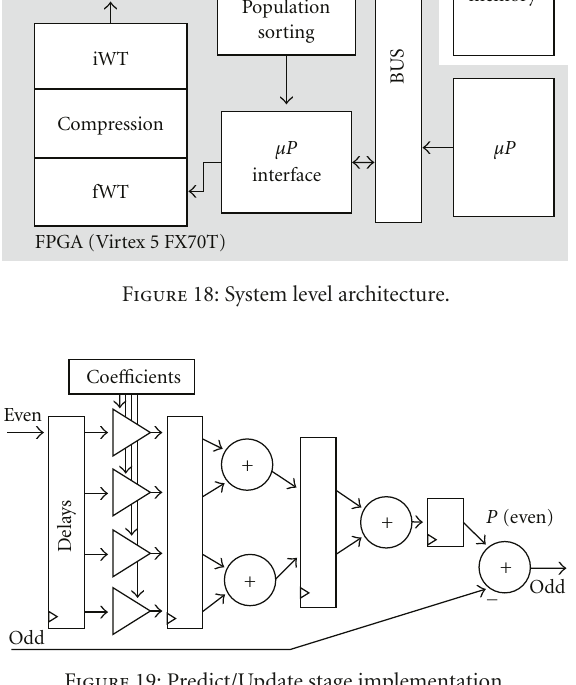
Figure 19: Predict/Update stage implementation.